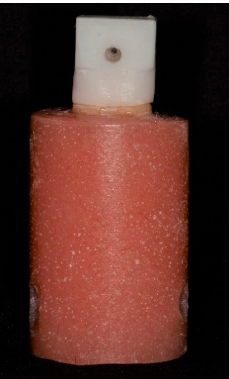
Figure 1. Zirconium oxide coping showing the design of the occlusal surface to enable removal post-cementation.